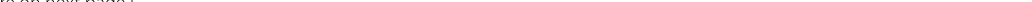
figure on next Fig. 1 MiR-181a-5p is expressed at low levels in FD BMSCs. a MicroRNA sequencing analysis showed the differentially expressed miRNAs between FD BMSCs and BMSCs. b Quantitative real-time PCR analysis was used to detect miR-181a-5p, miR-145-3p, miR-98-3p and miR-92b-5p expression between FD BMSCs and BMSCs. c cAMP levels in BMSCs treated with cAMP or IBMX were analyzed by ELISA. MiR-181a-5p, miR-145-3p, miR-98-3p and miR-92b-5p expression in BMSCs treated with cAMP ( d ) or IBMX ( e ) was analyzed by quantitative real-time PCR. f Quantitative real-time PCR analysis was used to detect miR-145-3p, miR-98-3p and miR-92b-5p expression in FD BMSCs transfected with miR-181a-5p mimics. g Quantitative real-time PCR analysis was used to detect miR-145-3p, miR-98-3p and miR-92b-5p expression in BMSCs transfected with miR-181a-5p inhibitor. h Venn diagram showing the number of miR-181a-5p target genes predicted by performing miRDB, miRPathDB, miRWalk, and TargetScan algorithms. i KEGG analysis of the target genes of miR-181a-5p. The data are presented as the mean S.E.M. values (n 3). # P > 0.05; * P < 0.05; *** P < ± ≥